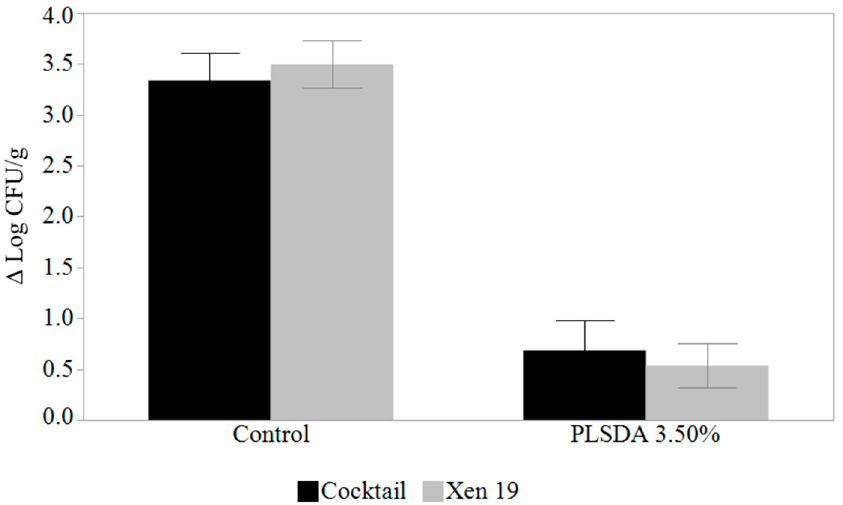
Figure 2. Comparison of growth after 12 days (N i –N 0 ) at 5 °C with a cocktail of L. monocytogenes associated with foodborne disease outbreaks and L. monocytogenes Xen19 on a miniature ham model. The initial inoculum was 4.8 ± 0.2 log CFU/g. ANOVA analysis found no significant difference between the cocktail of L. monocytogenes and L. monocytogenes Xen19 controlling for treatment effect ( p = 0.98).